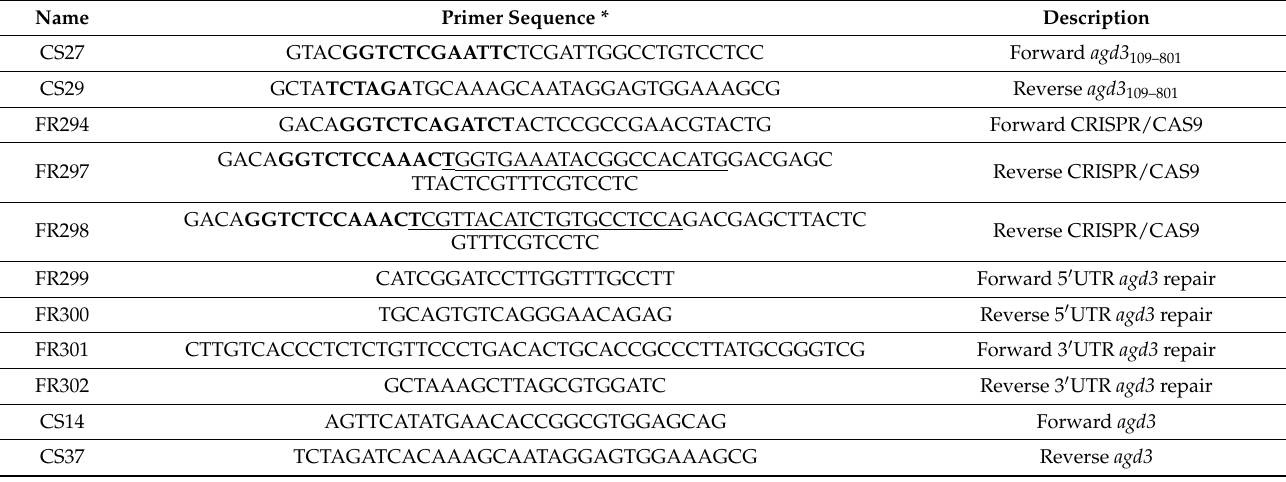
Table 1. Primers used in this